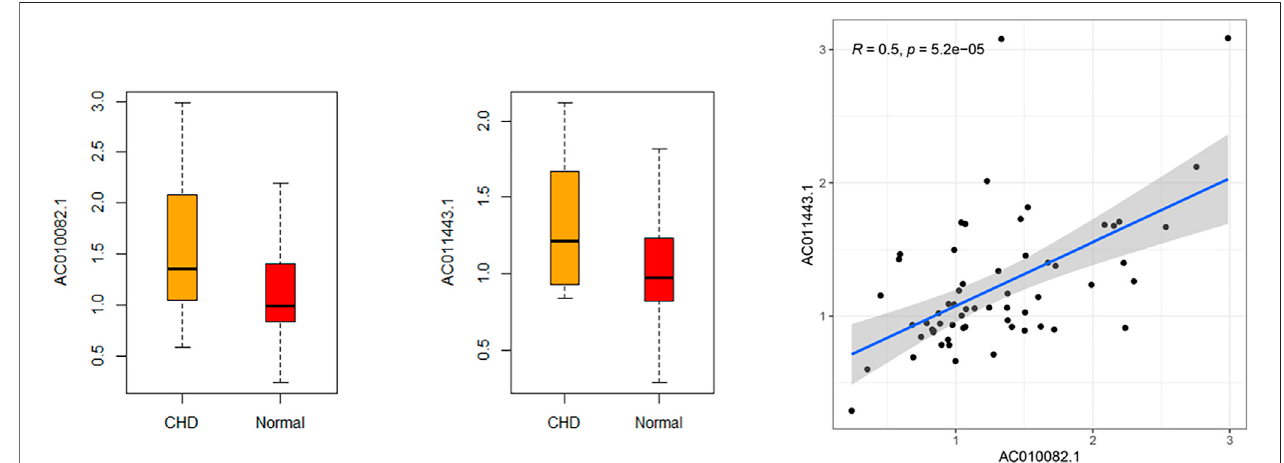
FIGURE 11 | Relative expression level and correlation of AC010082.1 and AC011443.1 in the validation cohort.